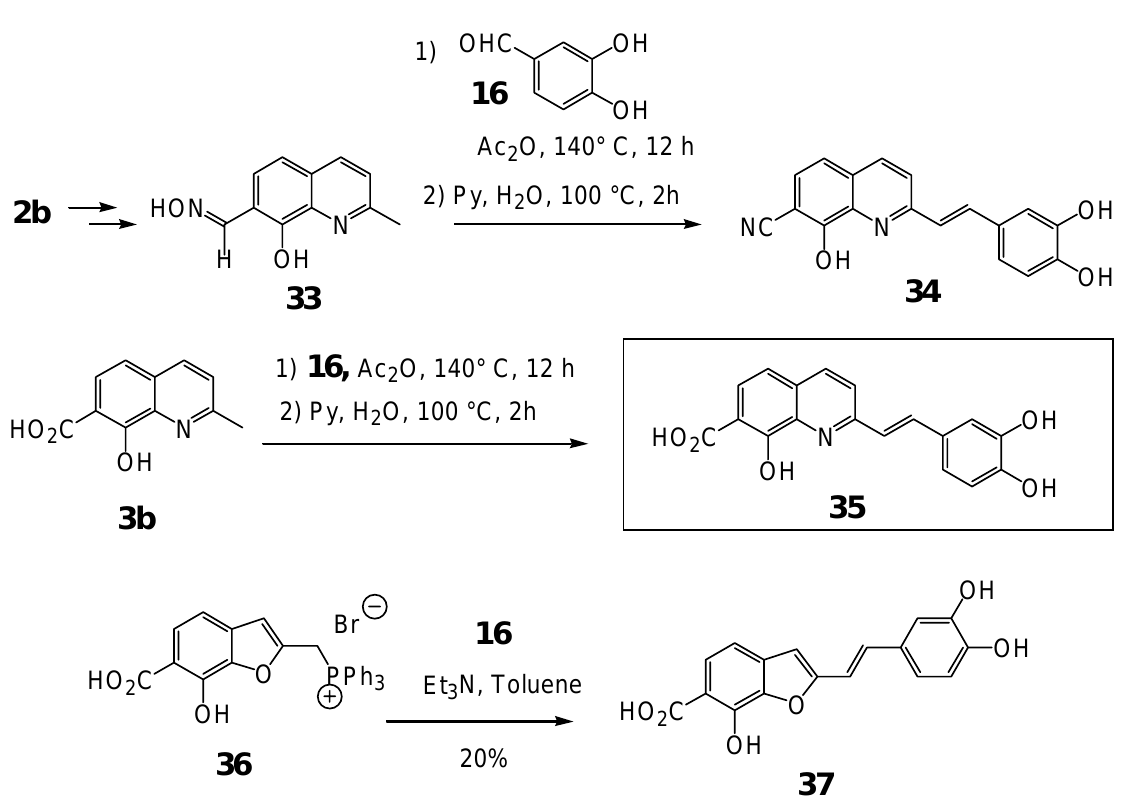
Scheme 3. Synthesis of 8-hydroxy-3',4'-dihydroxystyrylquinoline 7-carbonitrile (34 ), 7- carboxylic acid 35 and benzofuran 37